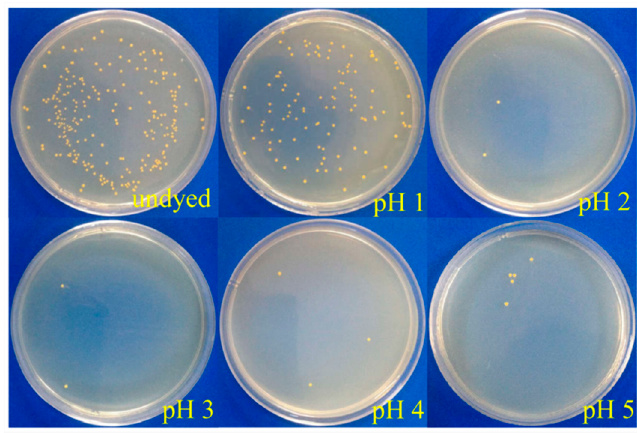
Figure 9. Antibacterial activity of cotton fabrics dyed under different pH values against S. aureus .